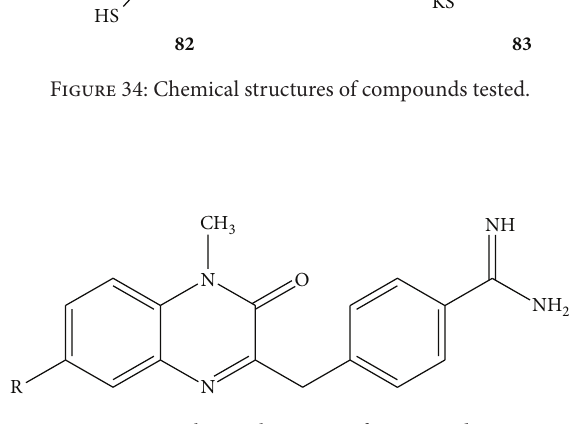
Figure 35: Chemical strucure of compound 84